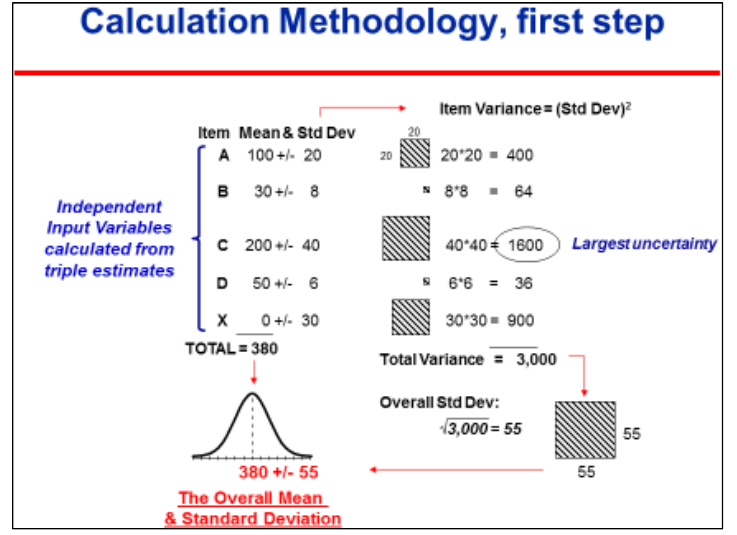
Figure 3. Main items ( A ) to ( D ) are evaluated while using triple estimates under firm normalized calculation assumptions, while ( X ) represents all potential external supplementary cost effects—so-called Overall Influences. From the triple estimates, mean and standard deviation are calculated according to normal rules. The hatched squares illustrate the standard deviation in second order—the variance. They represent the relative criticality, because the variance of the total equals the sum of all local variances. Item C, being the most critical uncertainty, is further specified. This is shown in Figure 4.